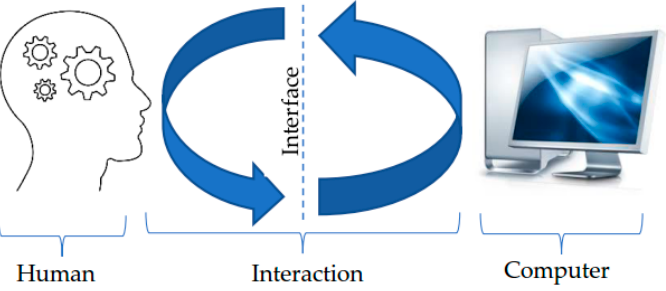
Figure 3. High-level diagram of a typical human–computer interaction (HCI).